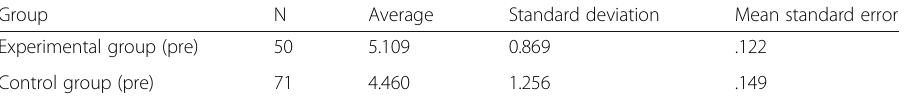
Table 1 Mean level of written production pre-treatment in experimental and control groups Group N Average Standard deviation